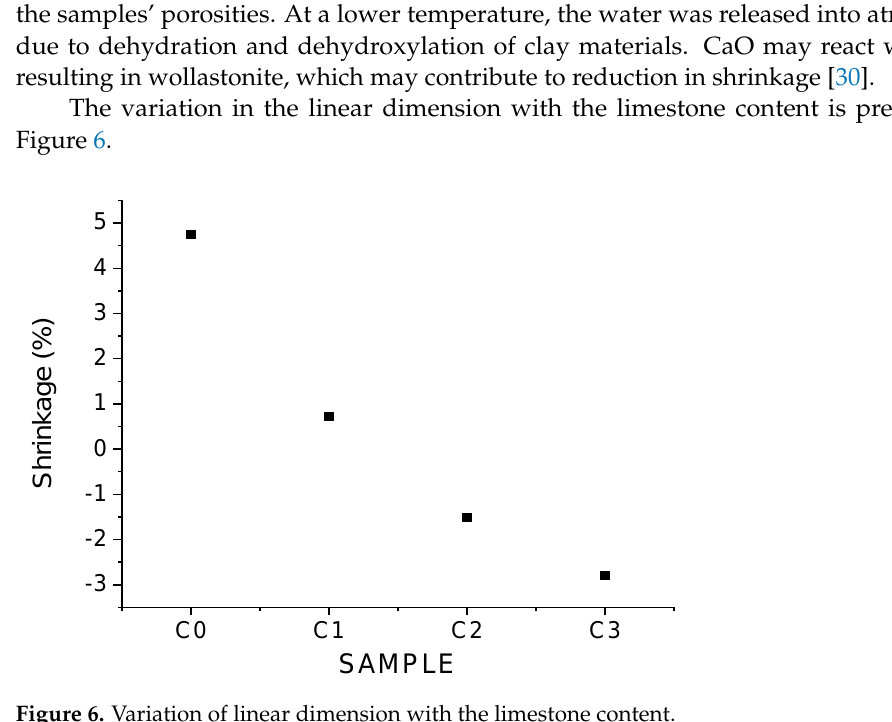
Figure 6. Variation of linear dimension with the limestone content.